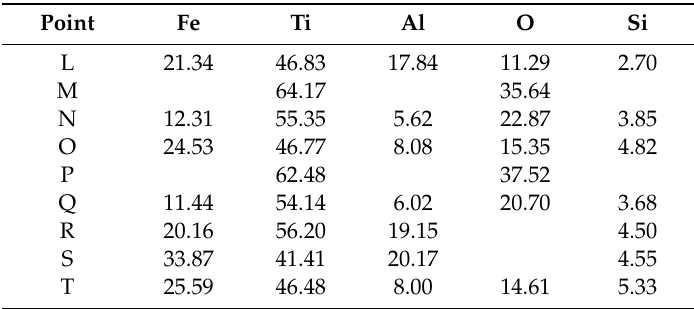
Table 3. The atomic proportions of phases in Figure 7,